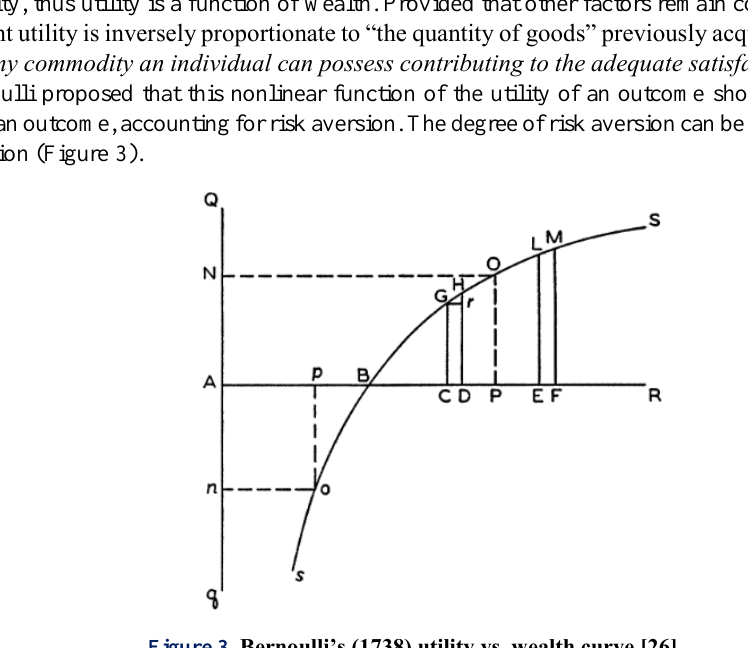
Figure 3. Bernoulli’s (1738) utility vs. wealth curve